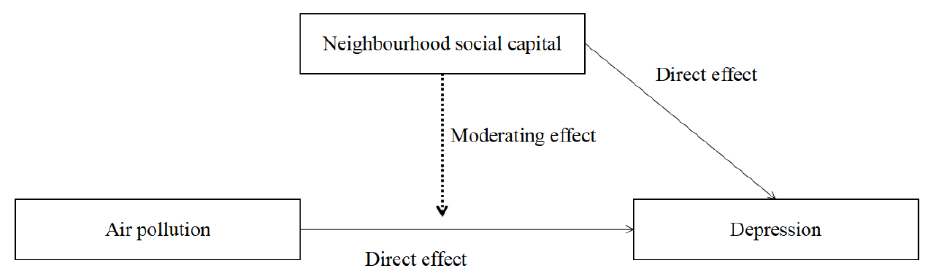
Figure 1. Conceptual model of the moderating relationship of neighbourhood social capital on the relationship between air pollution and depressive symptoms.